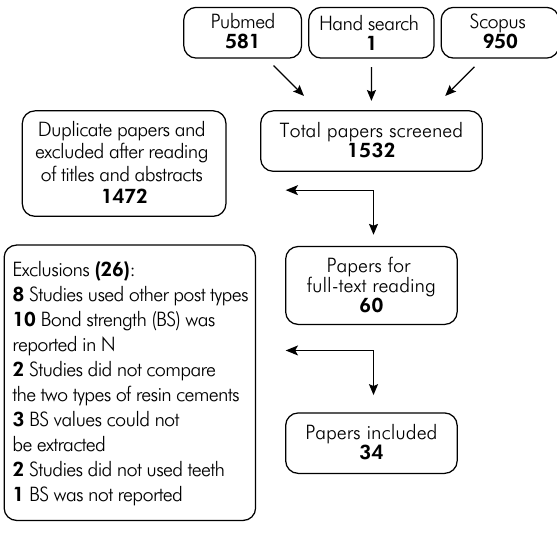
Figure 1. Flow diagram of the study according to the PRISMA